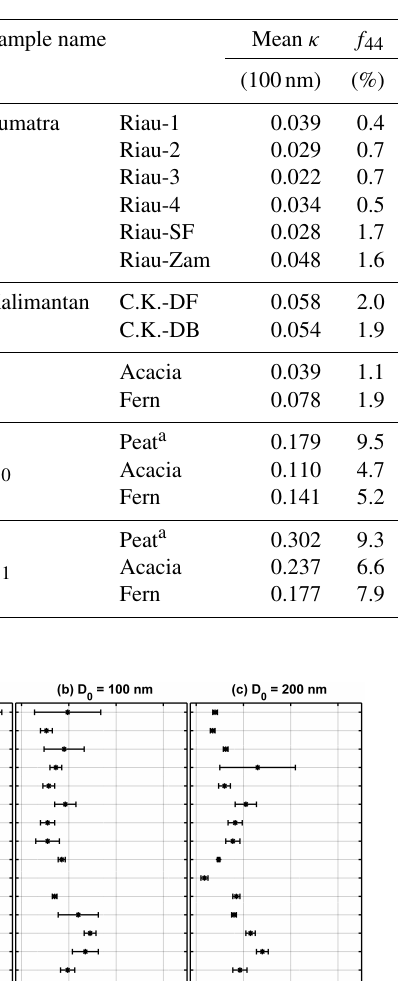
Table 3. Summary of chemical characteristics of different types of Indonesian peat and biomass burning particles.